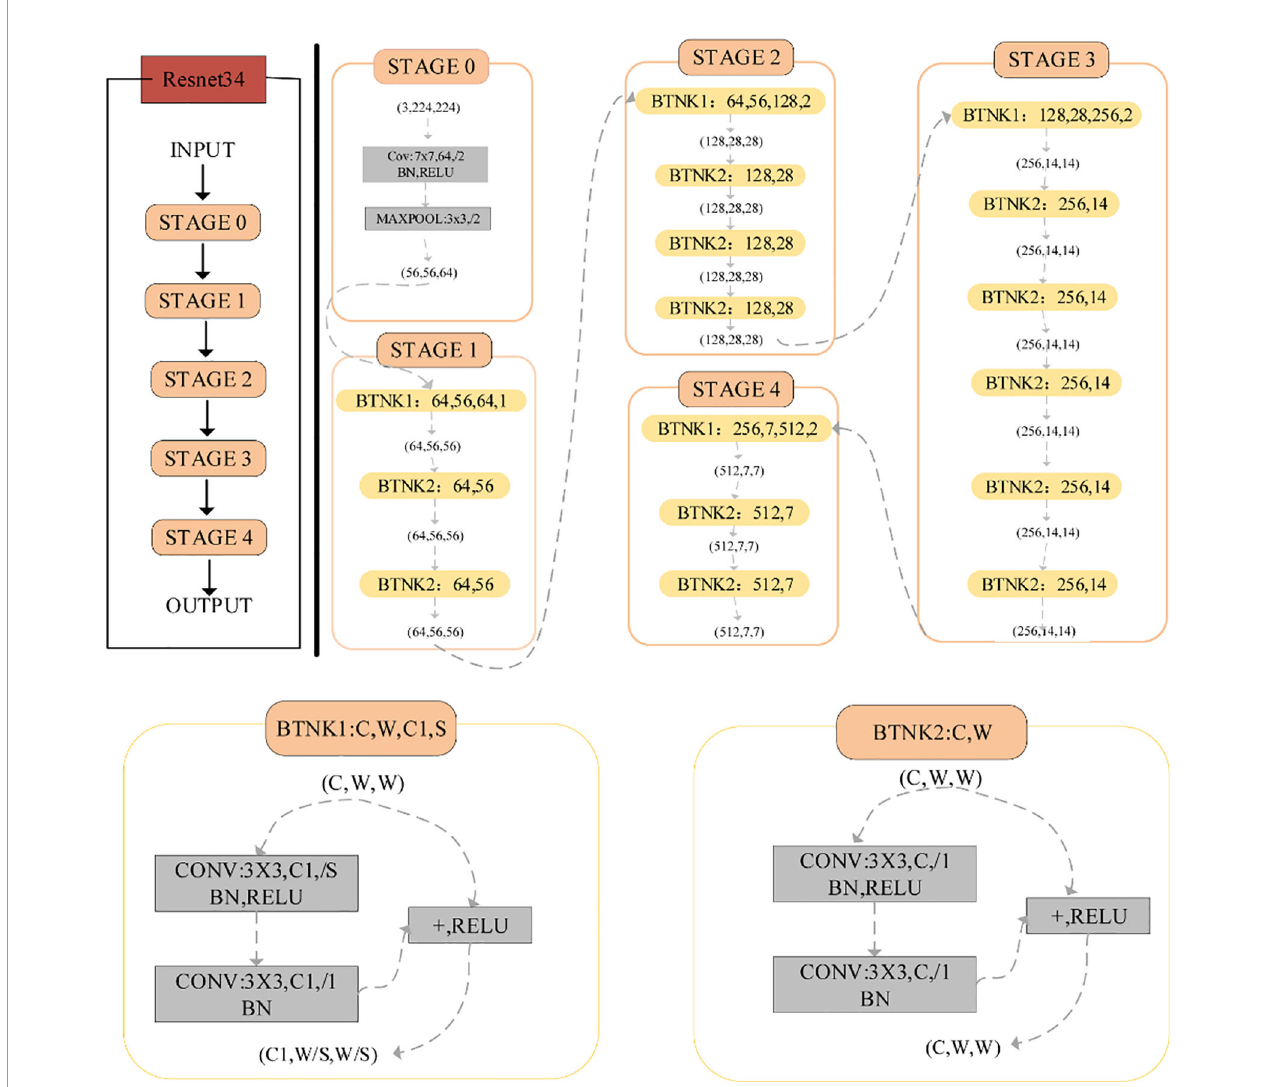
FIGURE 1 | The network architecture of